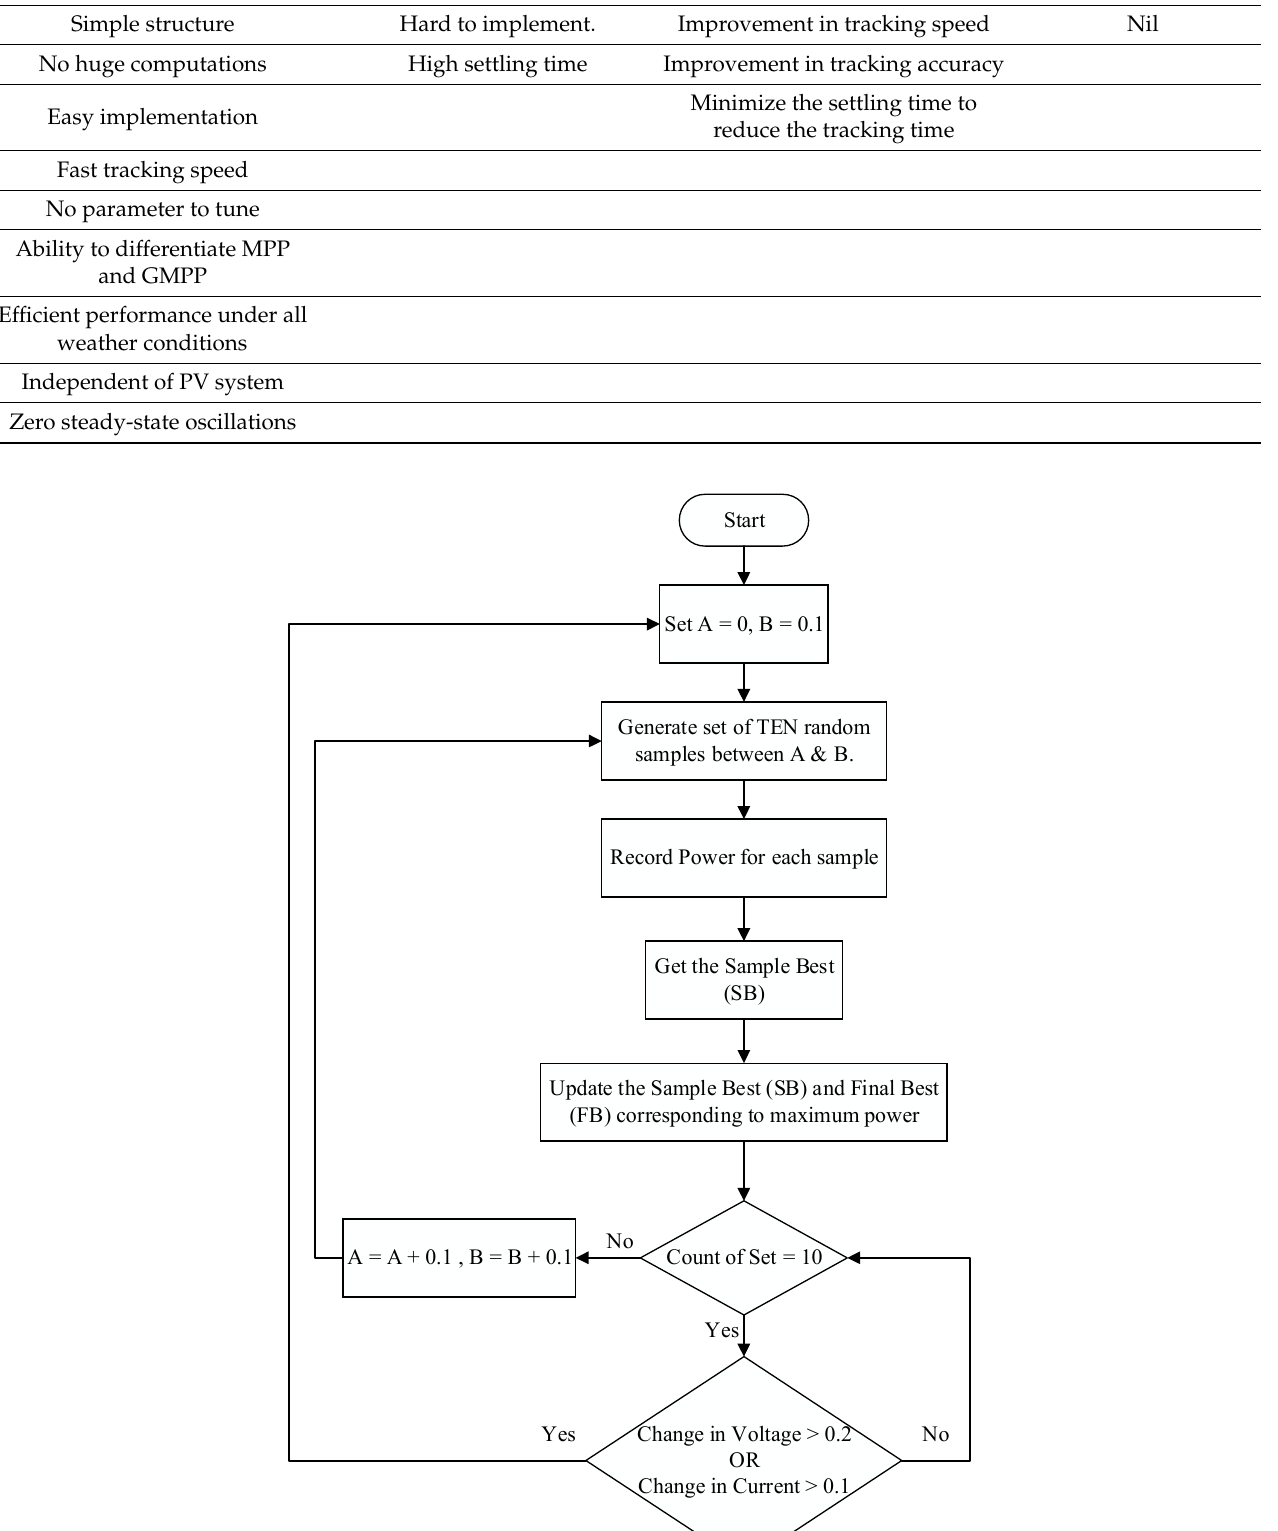
Table 1. SWOT analysis of TCA algorithm. Strengths